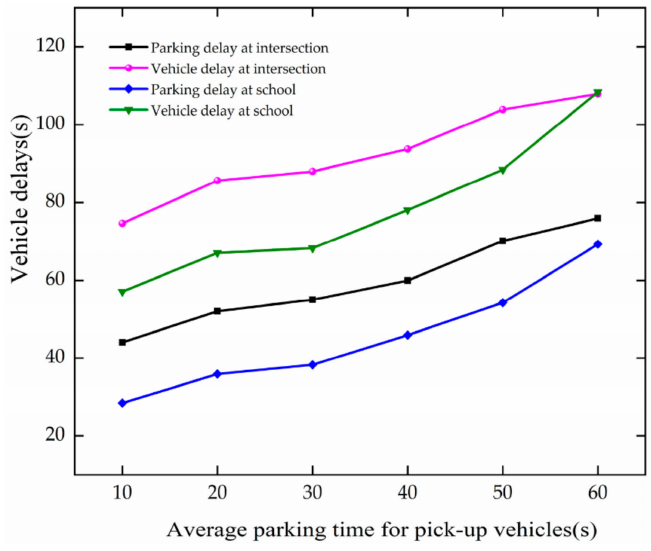
Figure 26. Variation trend of vehicle delay with